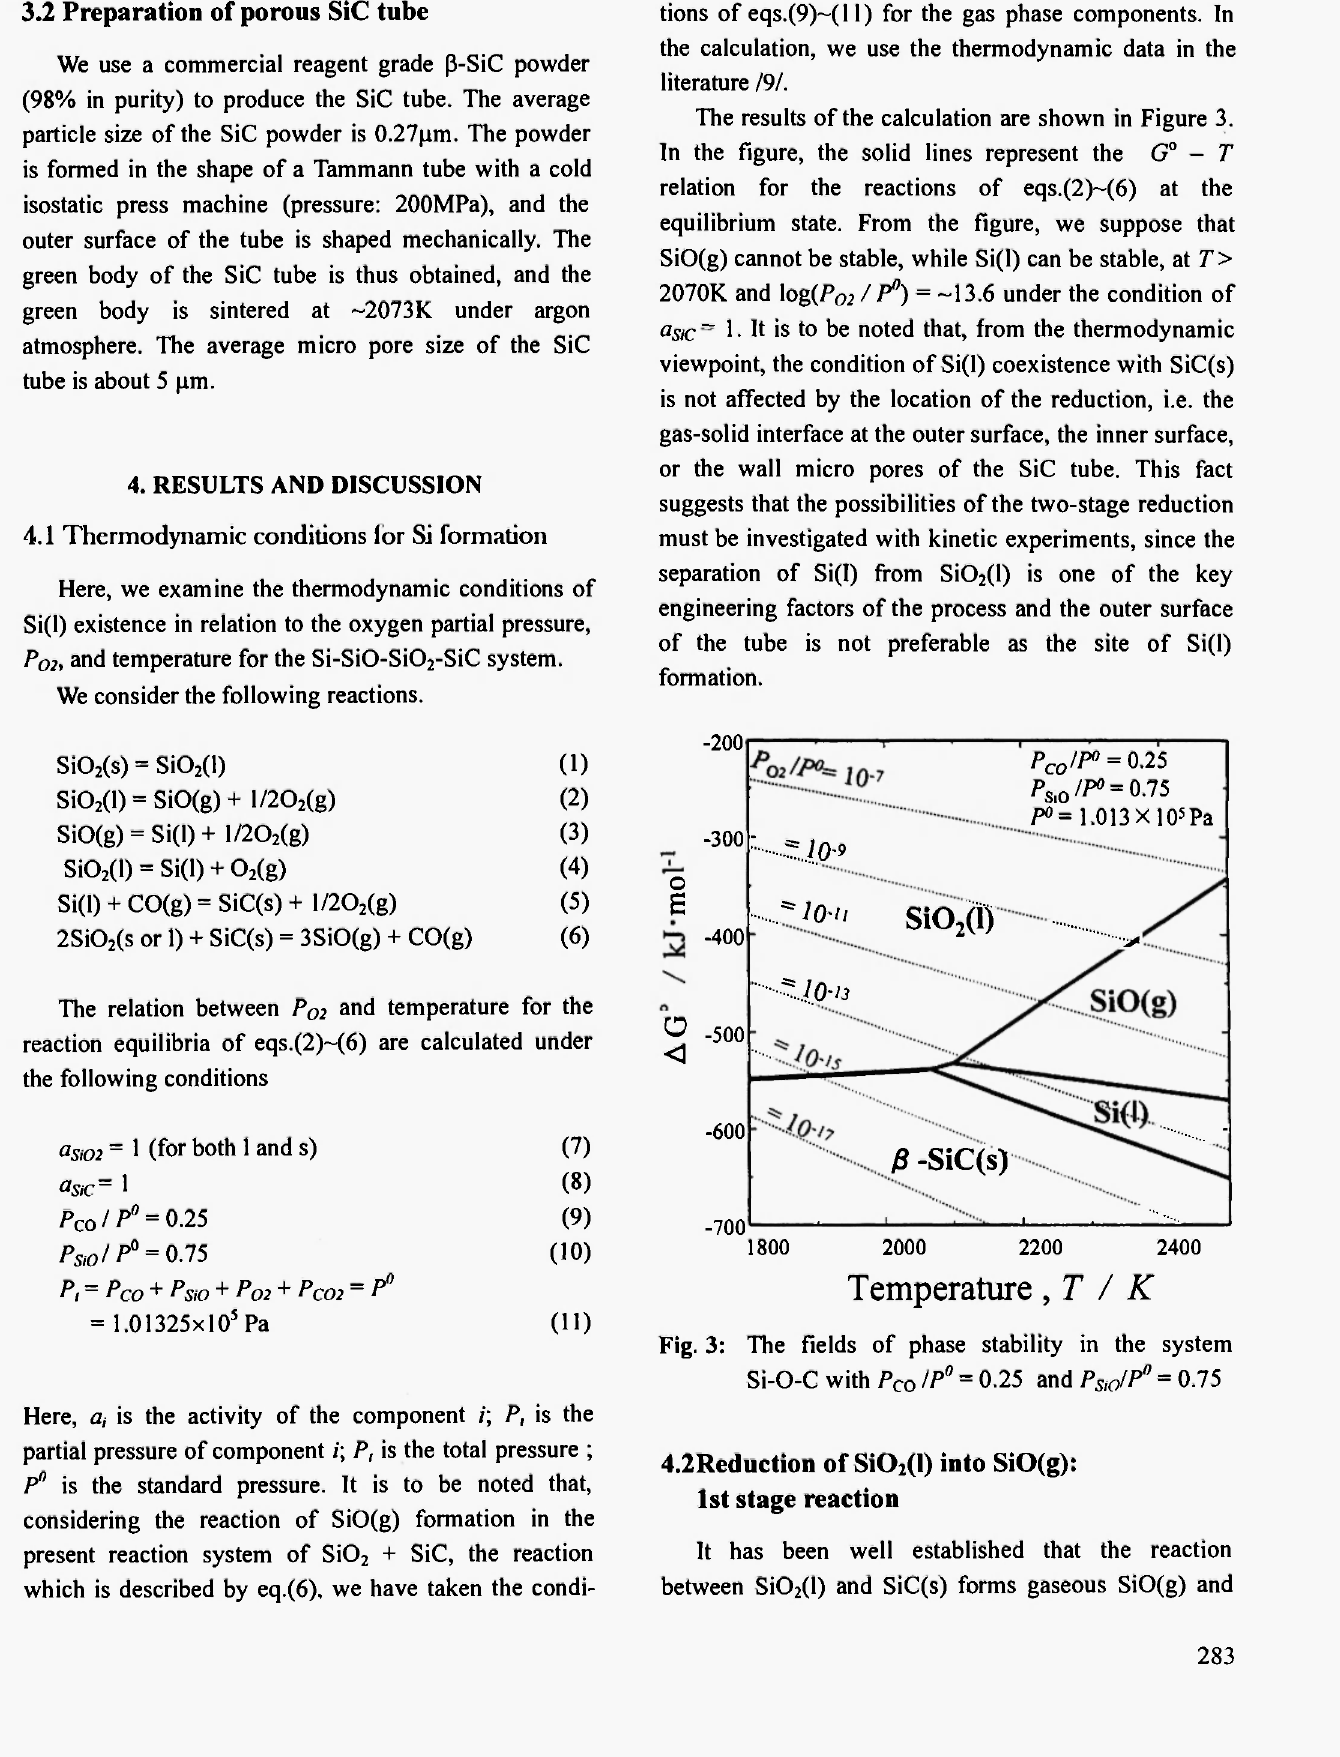
3: The fields of phase stability in the system Si-O-C with P /P° = 0.25 and P co